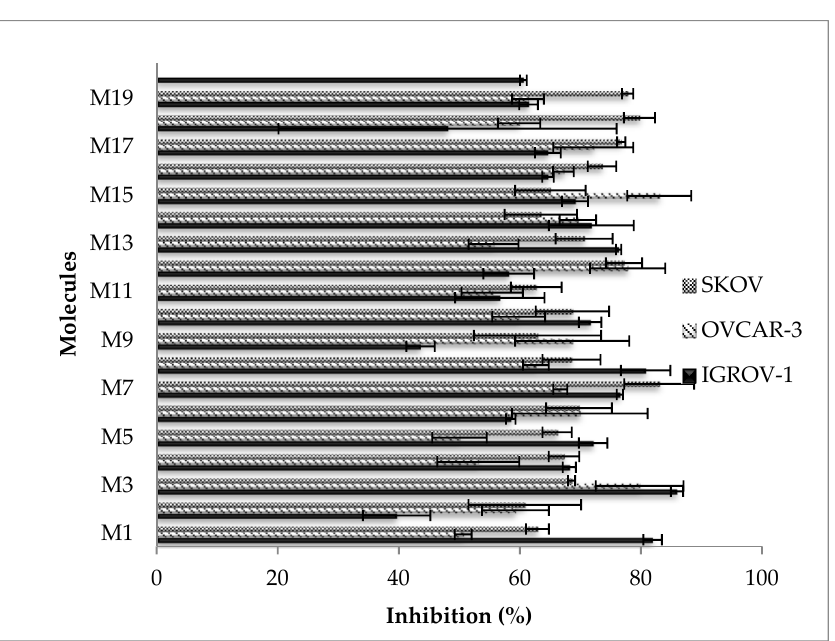
Figure 2. Cytotoxic activity of flavones (100 µM) against the SKOV, OVCAR-3, and IGROV-1 cancer cell lines. Table 4. Anti-cancer activity: the IC 50 (µM) values of flavones tested against HCT 116, MCF 7 SKOV, and OVCAR-3 cancer cell lines (IGROV-1 was not available to establish the IC 50 ).